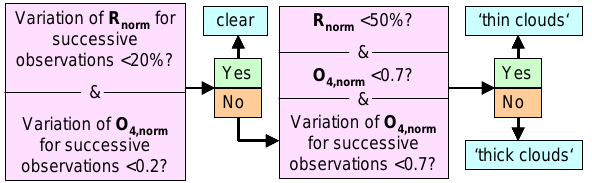
Fig. 14 Schematic description of the cloud classification scheme. R norm indicates the normalised radiance (Eq. 18), O 4,norm indicates the normalised O 4 DAMF (Eq. 19). The ‘&’- sign indicates that all conditions have to be fulfilled to get a 'yes' decision.